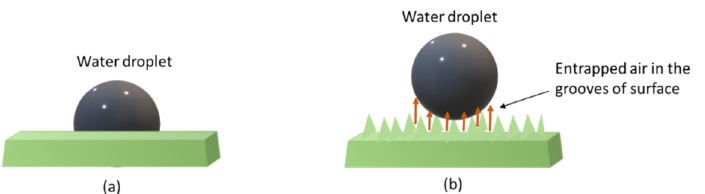
Figure 12. A schematic illustration of a water droplet on ( a ) smooth and ( b ) rough surfaces.